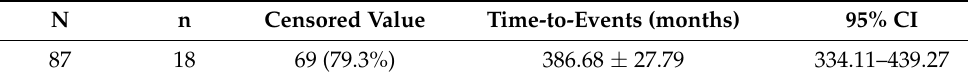
Table 4. Postoperative complications.